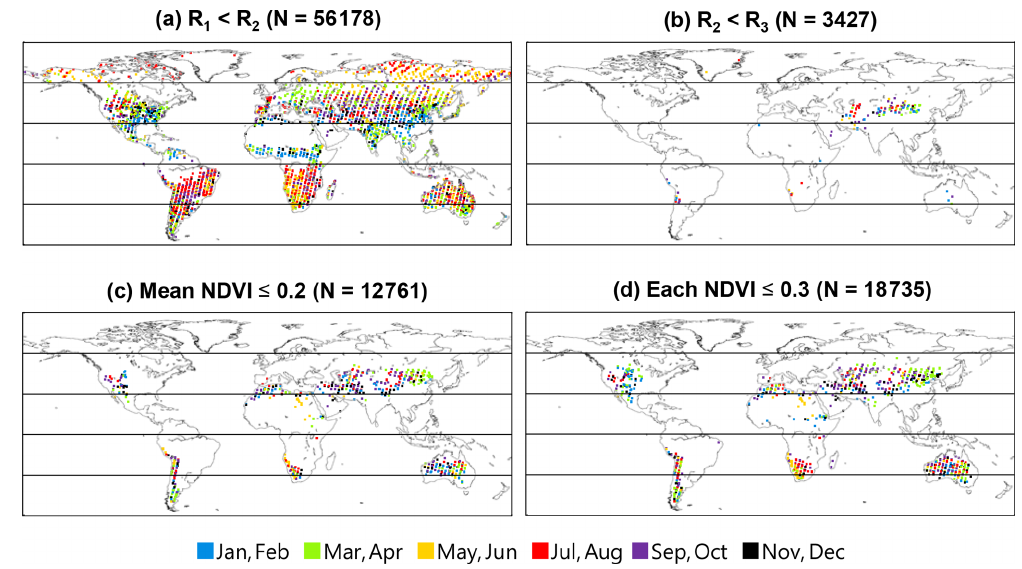
Figure 2. Locations of data identified as the candidates for vegetation-free areas by the albedo values ( R i for TANSO-FTS band i ) or NDVI values for P polarization in 2016: (a) R 1 < R 2 ; (b) R 2 < R 3 ; (c) mean NDVI ≤ 0.2; (d) NDVI max ≤ 0 . 3. The numbers of data points ( N ) are also presented.